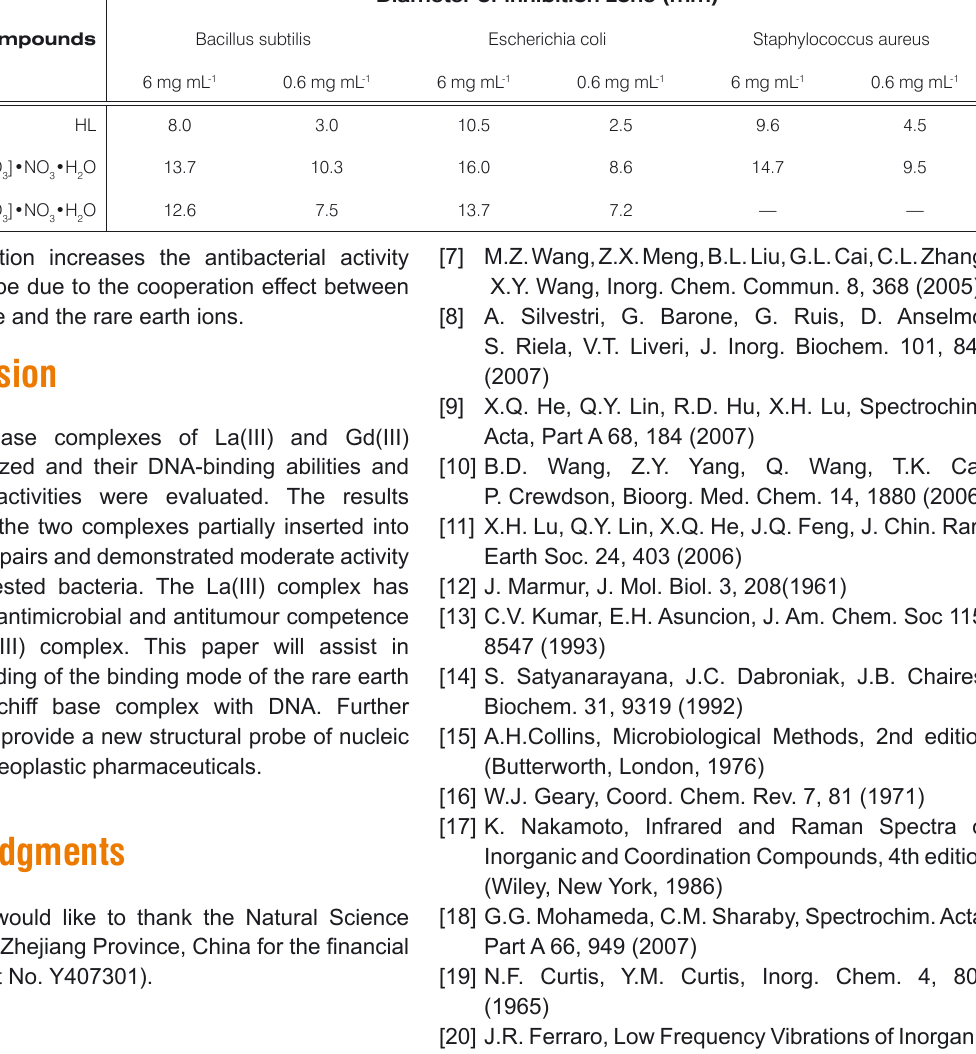
Table 1. The in vitro antibacterial activities of the Schiff base and their complexes